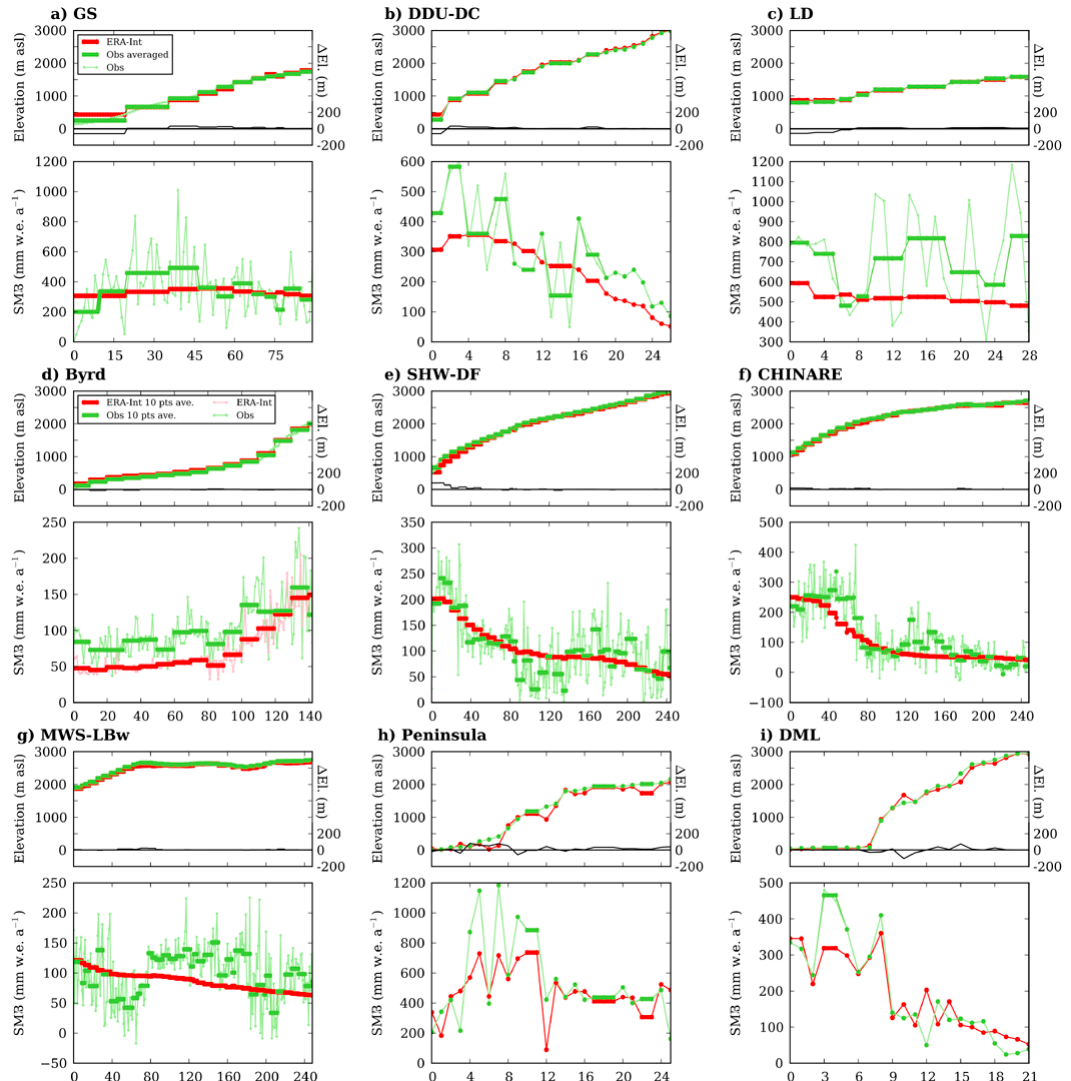
Fig. 8. Surface elevation (“El”) and variations in the SMB in specific areas and along traverses from the coast to plateaus where field data are available: (a) along the GLACIOCLIM-SAMBA observation transect in Adelie Land, (b) between Dumont d’Urville (DDU) station and Dome C (DC), (c) around Law Dome, (d) in Byrd Station region and on Ross Ice Shelf (Byrd), (e) between Syowa (SHW) and Dome Fuji (DF) (f) along the traverse route from Zhongshan station to Dome A (CHINARE) (g) along the west side of Lambert glacier (LBw) close to Mawson station (MWS) (h) in the Antarctic Peninsula (i) in Dronning Maud Land (DML). For each region, surface elevation values are presented in the upper panel and SMB values in the lower panel. Values calculated by ERA-Interim (thick red line) are compared with the mean of field data included in each EAR-Interim grid cell (thick green line). Point field data before averaging are represented by a thin light green line. The surface elevation of field observations is from Bamber et al. (2009) digital elevation model (DEM). Also shown in the upper panels are the differences in surface elevation between ERA-Interim and Bamber et al. (2009) DEM ( 1 El, black line, right